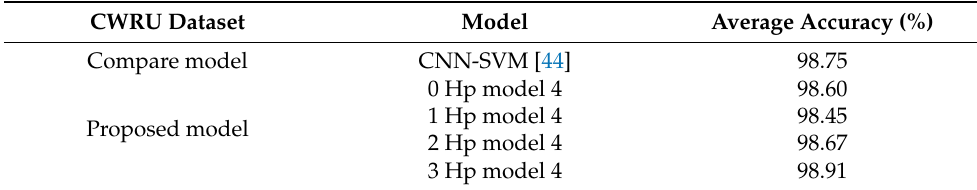
Table 11. Comparison of neural support vector